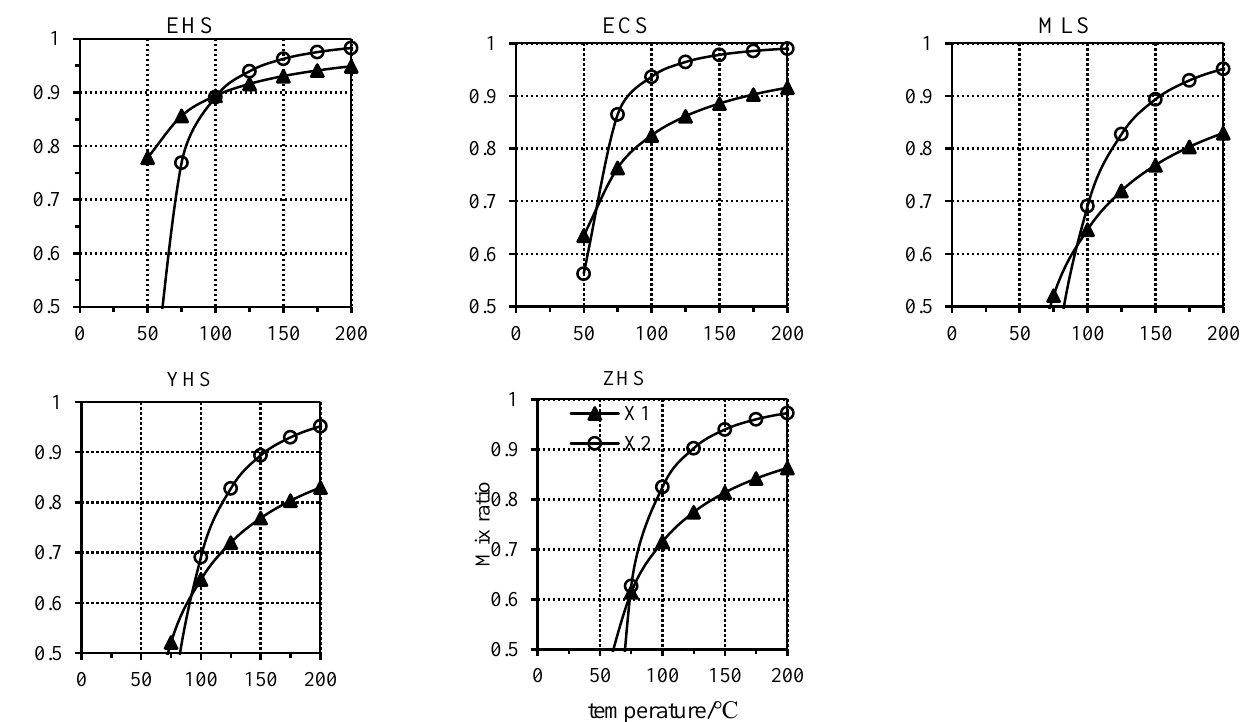
Figure 9. Scale diagram of the temperature of the hot deep water of the individual hot springs—mixed with cold water.